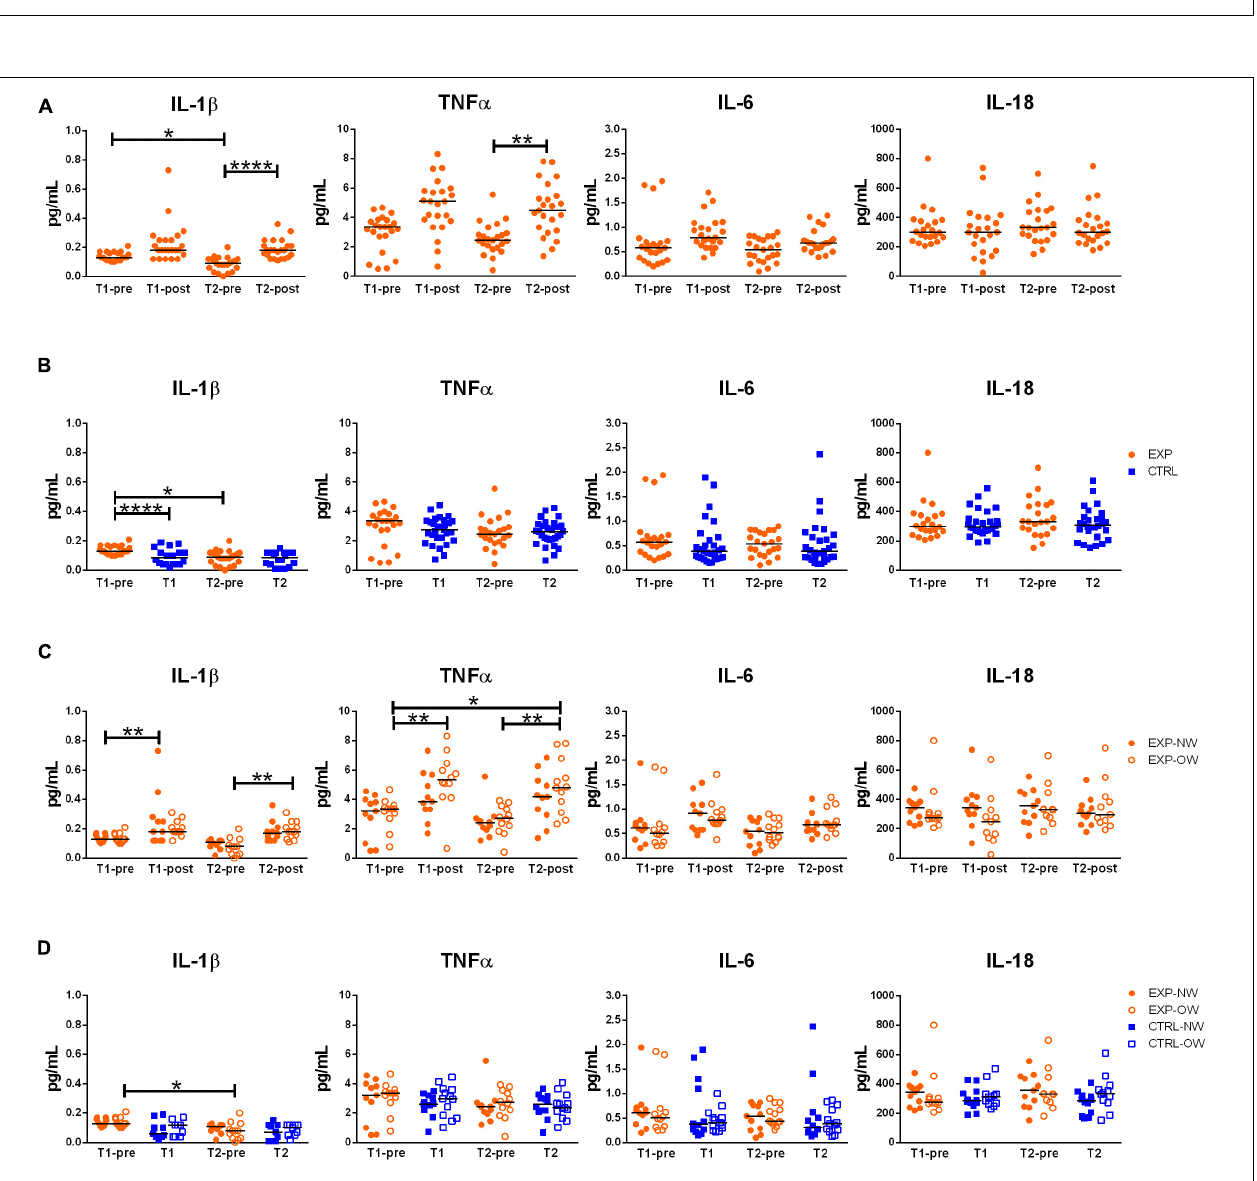
FIGURE 2 | Expression of inflammasome-related genes in whole blood samples. Fold change of NLRP3 and TLR4 gene expression, normalized on PPIB and PGK1, in whole blood from elderly women underwent a 12-week aerobic Nordic walking training program (EXP, n = 29) and untrained controls (CTRL, n = 35). (A) Expression of NLRP3 and TLR4 in the whole EXP group before and after the first (T1-pre and T1-post) and the last (T2-pre and T2-post) sessions of Nordic walking. (B) Expression of NLRP3 and TLR4 in the whole EXP group (orange dots), before the first and the last (T1-pre and T2-pre) Nordic walking session, and in the CTRL (blue squares) over the same observation period (T1, T2). (C) Expression of NLRP3 and TLR4 in the whole EXP cohort, grouped based on BMI in normal weight (NW, full dots) and overweight (OW, empty dots) subjects. (D) Expression of NLRP3 and TLR4 in the EXP (orange dots) and CTRL (blue squares) cohorts, grouped based on BMI in normal weight (NW, full symbols) and overweight (OW, empty symbols) subjects. Asterisks indicated significant differences according to the different statistic tests applied: * p < 0.05; ** p < 0.01; *** p < 0.001.